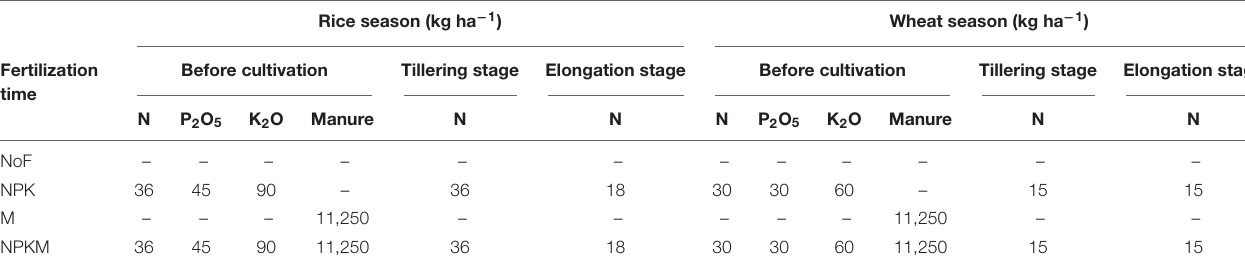
TABLE 1 | Application rates of fertilizers in the long-term